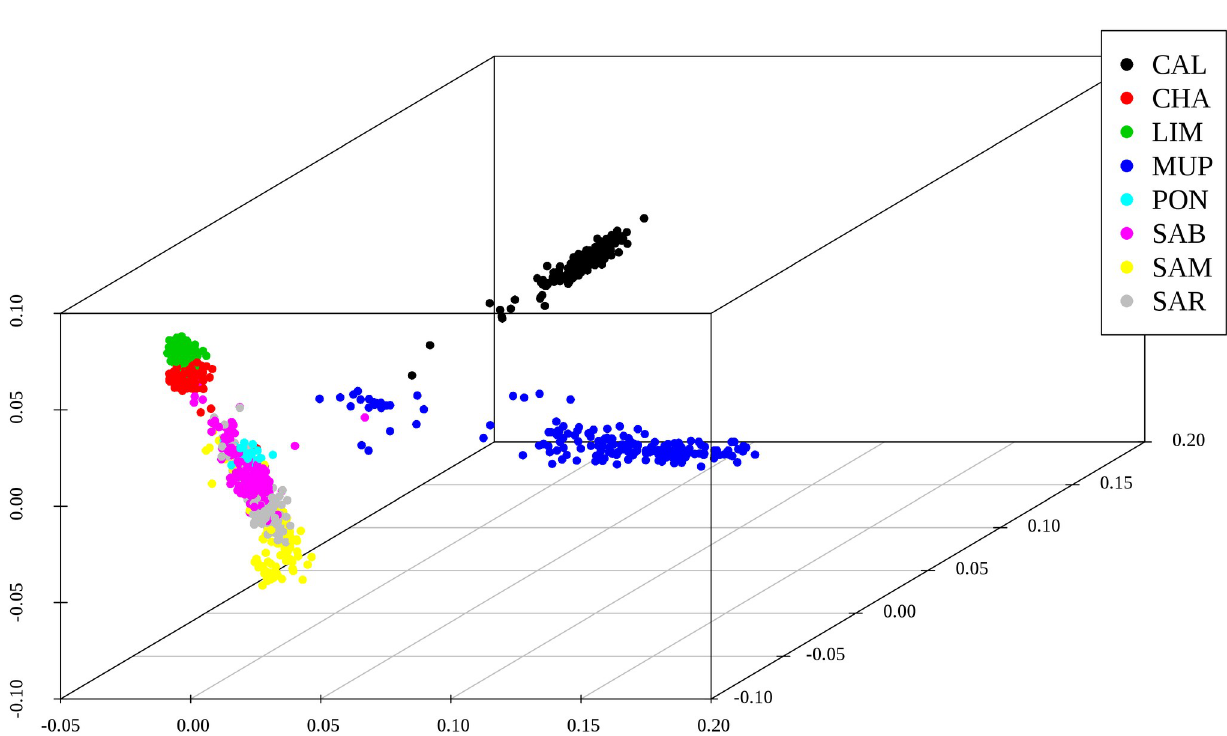
Fig 3. Multidimensional scaling plot for 8 cattle beef breeds, where CAL = Calvana; CHA = Charolais; LIM = Limousine; MUP = Mucca Pisana; PON = Pontremolese; SAB = Sardo Bruna; SAM = Sardo Modicana; SAR = Sarda.